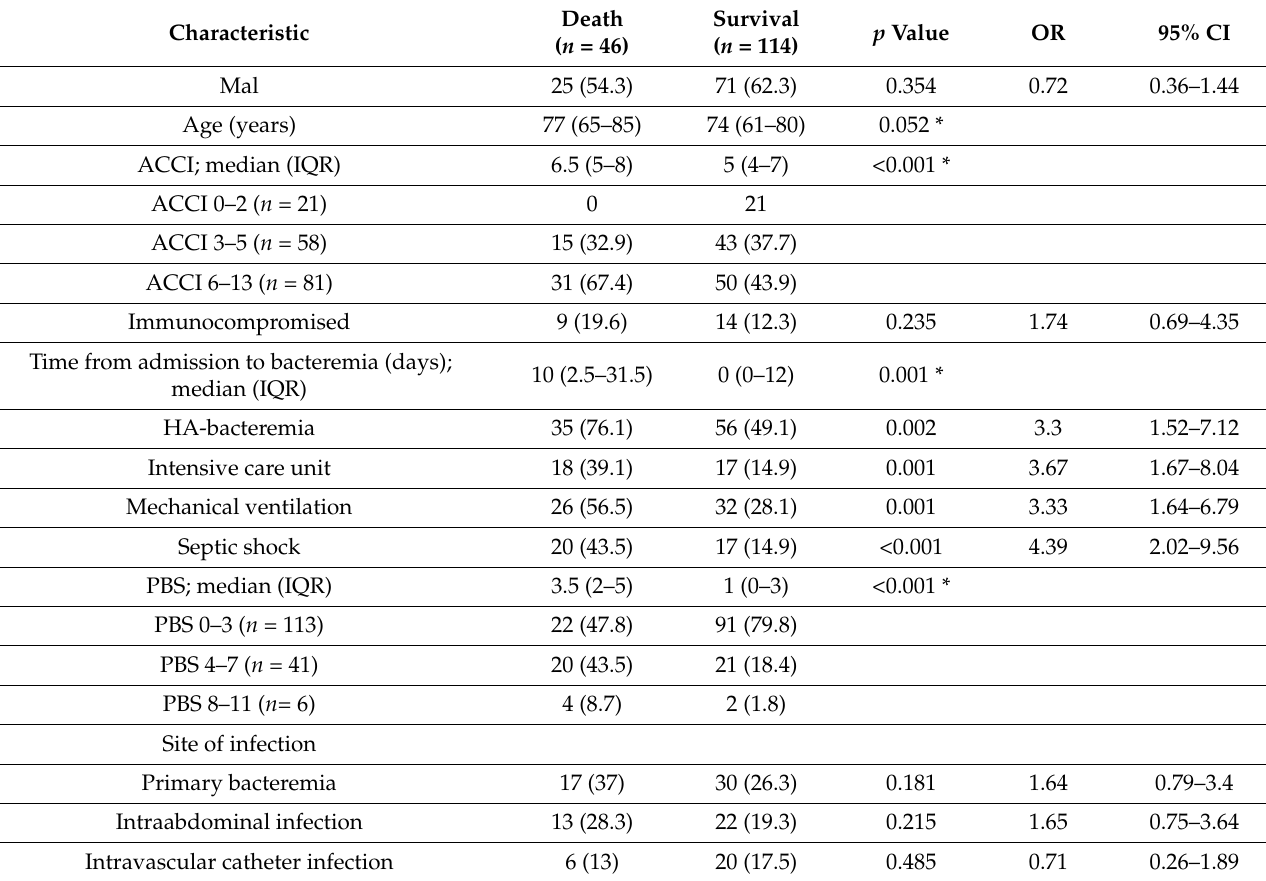
Table 2. Comparison of the characteristics between survivors and no survivors within 30-days